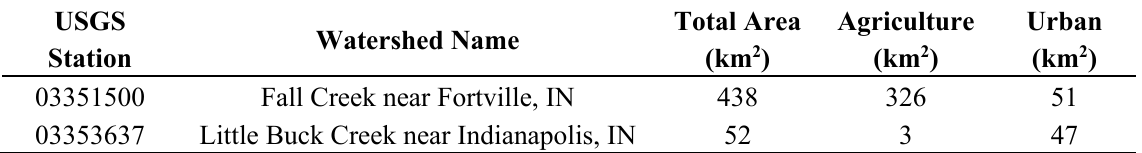
Figure 5. Location of USGS stations to estimate annual sediment loads. Table 1. Dominant land uses in